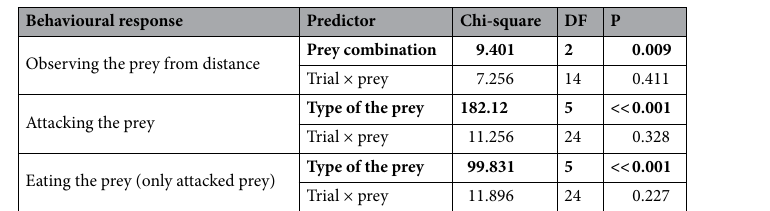
Table 1. Effects of tested predictors on behaviour of avian predators (Generalized or Linear Mixed-effect Models, likelihood ratio tests). DF degrees of freedom. Significant effects in bold.